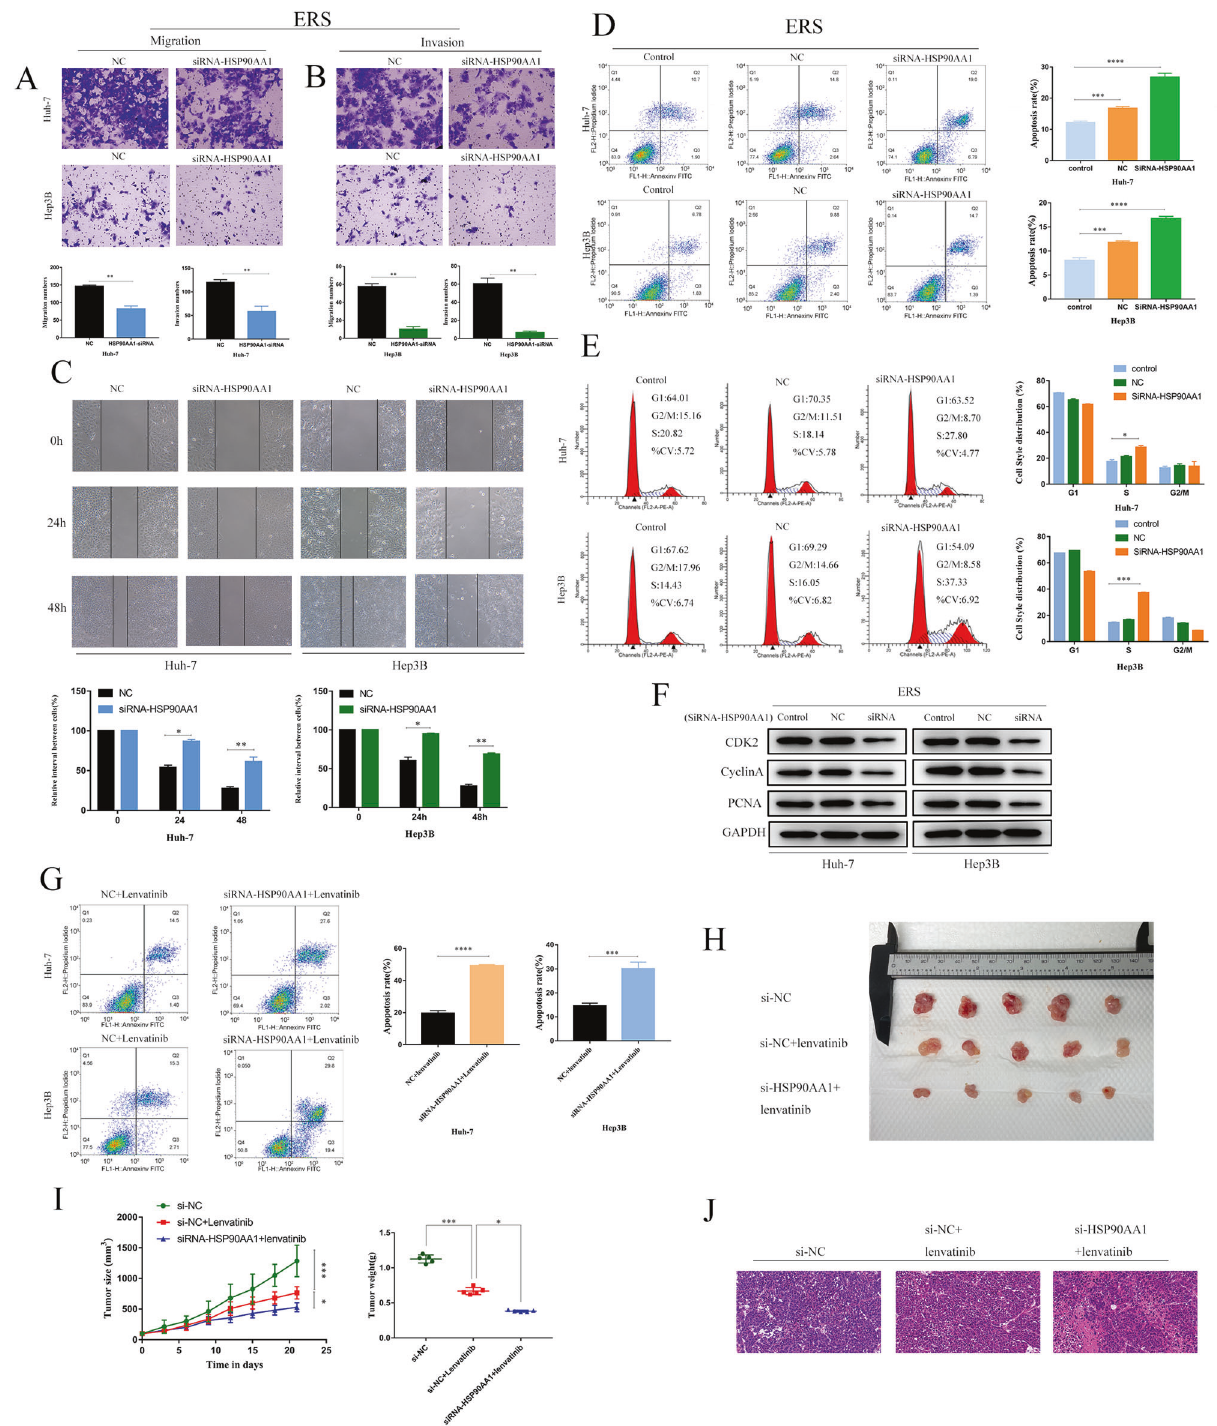
Fig. 7 HSP90AA1 promotes metastasis, cell cycle arrest, channeling resistance, and Lenvatinib resistance in ERS hepatocellular carcinoma. After siRNA-NAT10 or Remodelin treatment, Huh-7 ( A ) and Hep3B ( B ) cell migration and invasion were analyzed by transwell, scale = 200 μ m. C Similarly, the migration of Huh-7 and Hep3B cells was analyzed by wound healing assay (scale = 100 μ m). D The effect of siRNA-HSP90AA1 knockdown on the apoptosis of Huh-7 and Hep3B cells was analyzed by fl ow cytometry ( n = 3). E siRNA-HSP90AA1 increased the S-phase fraction of Huh-7 cells by fl ow cytometry analysis ( n = 3). F Western blot showed the expression levels of CDK2, CyclinA, and PCNA cell cycle proteins in Huh-7 and hep3B cells after HSP90AA1 knockdown or inhibition. G Flow cytometry analysis of the effect of siRNA-HSP90AA1 knockdown and inhibition on the sensitivity of Huh-7 cells and Hep3B cells to Lenvatinib ( n = 3). H Photographic images of xenograft tumors collected ( n = 5). I Average weight and volume of the mouse xenograft tumor on day 21. J HE staining of mouse metastatic tumors. All groups of cells were induced by TM 24 h in advance. All data were shown as mean ± standard deviation. * P < 0.05, ** P < 0.01, *** P < 0.001.